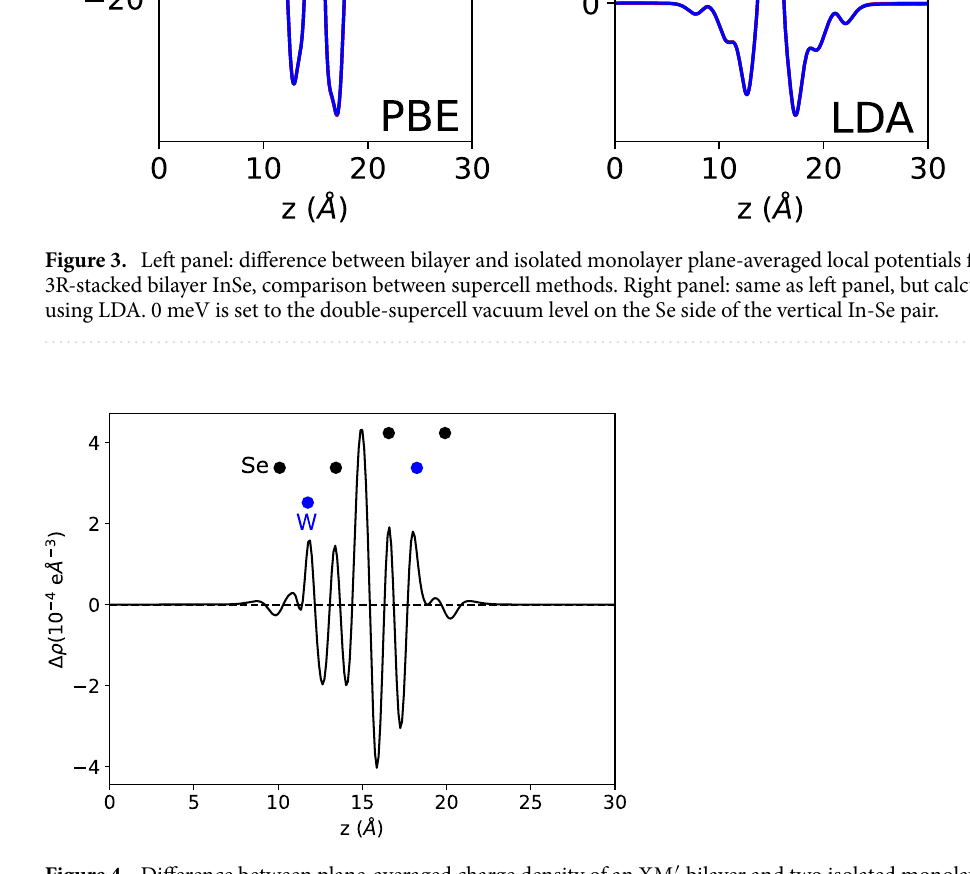
To demonstrate the latter, in Fig. 4 we show the z -coordinate dependence of the difference between the plane- averaged charge density of XM ′ stacked bilayer WSe 2 and that of two isolated WSe 2 monolayers. The greatest differences and charge transfer are to be found in the interlayer region, with a peak and a trough close to the